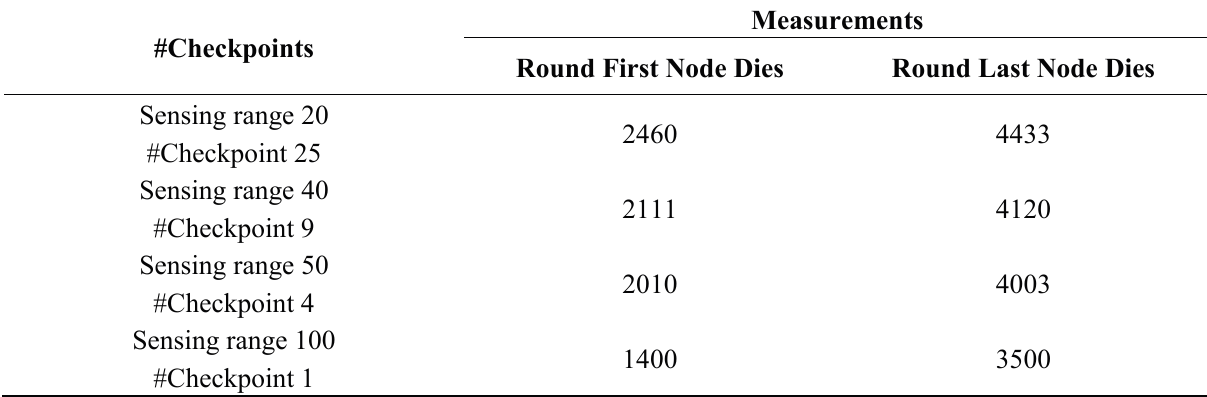
Table 4. Simulation results for the network life time using different number of checkpoints.